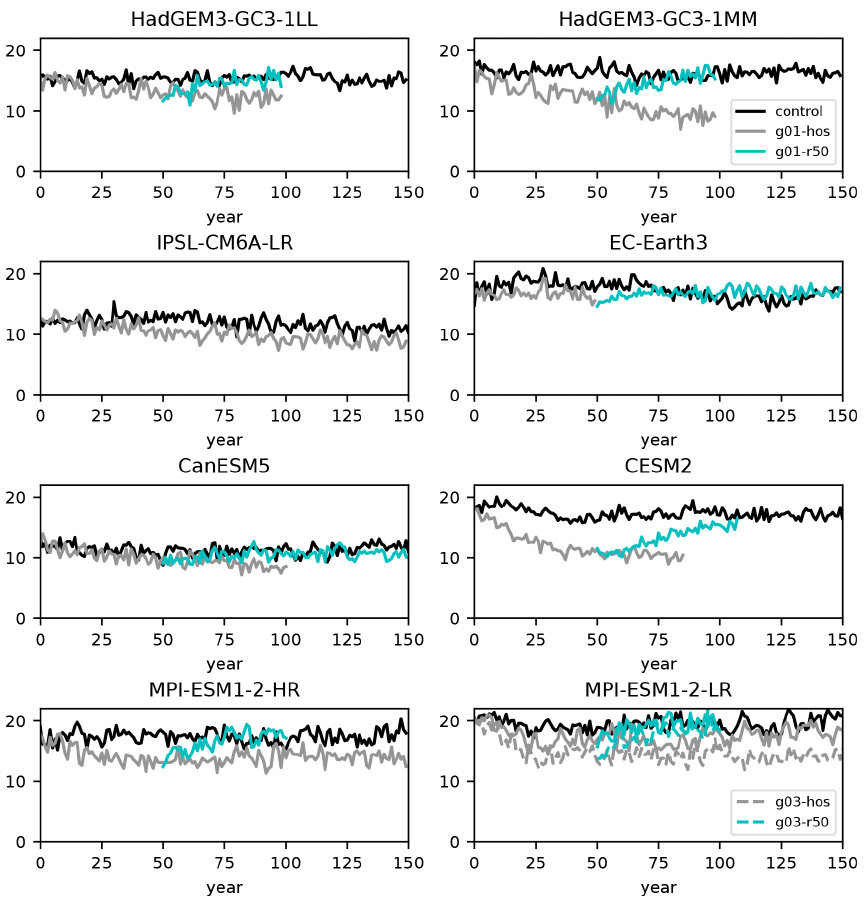
Figure 5. AMOC strength (maximum in depth at 26.5 ◦ N) for GH experiments. Each panel shows experiments conducted with different models. Experiments are the control (black), g01-hos (grey), and g01-r50 (cyan). MPI-ESM1-2-LR also shows the same experiment with a stronger hosing rate of 0.3Sv (dashed